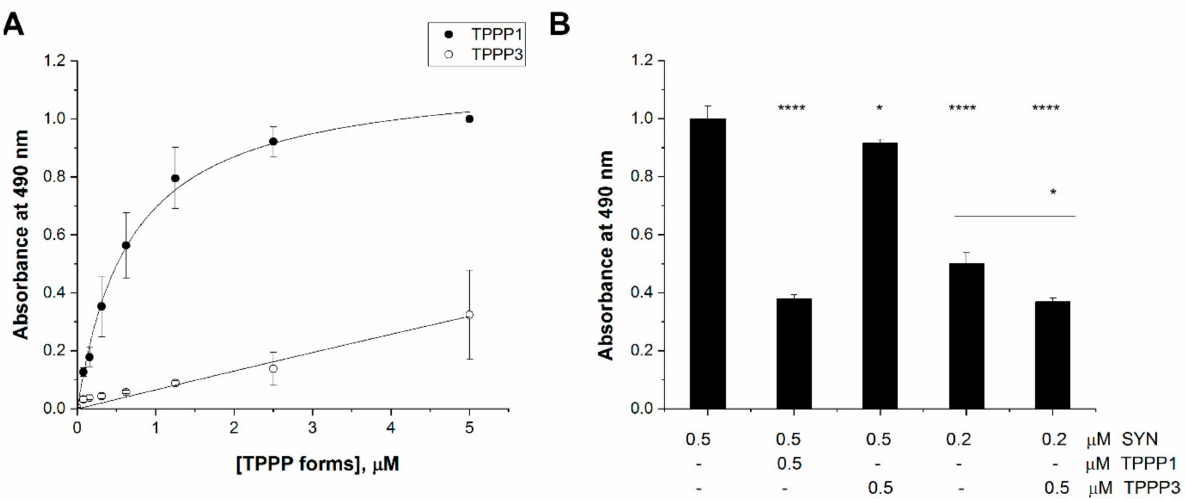
Figure 7. Interaction of TPPP3 with SYN compared to that of TPPP1. ( A ) In an ELISA experiment, the plate was coated with SYN, then human recombinant TPPP1 ( • ) or TPPP3 ( concentrations and the bound proteins were detected by specific antibodies. The binding affinities were evaluated by curve fitting, assuming simple hyperbolic saturation: 673 ± 58 nM for TPPP1. ( B ) In the competitive ELISA experiments, SYN alone or with TPPP3 was added to the immobilized TPPP1 and the binding of SYN was quantified by SYN antibodies. The normalized results are presented as means ± of the standard deviation (SD). Statistical comparisons were performed with two-sided, unpaired Student’s t -test, as compared to the control or as the lines indicate (* p < 0.05 and **** p <